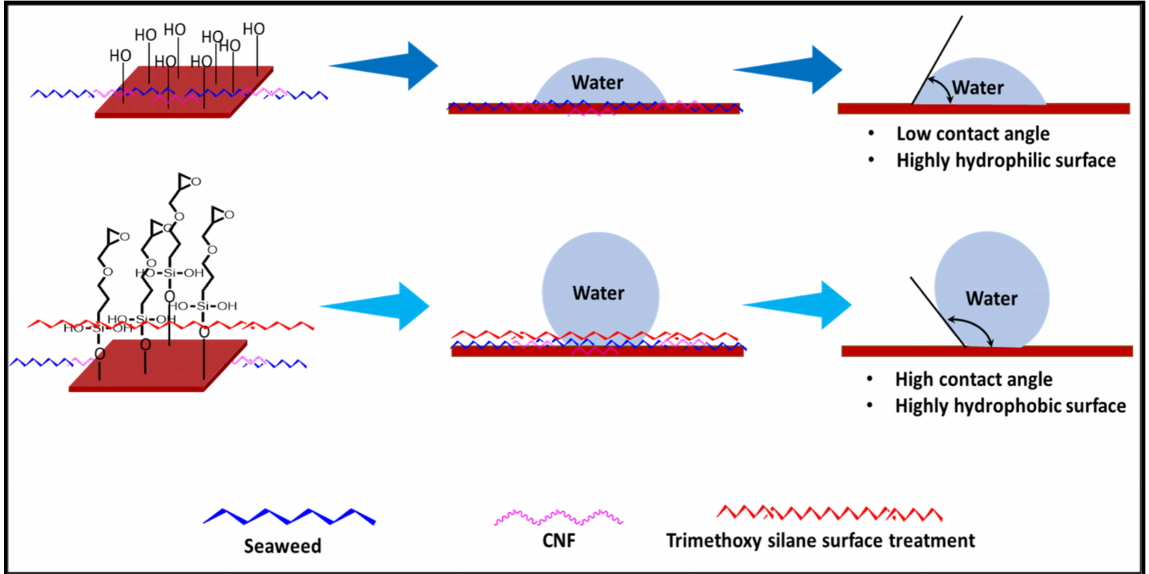
Figure 4. Silane modification effect on seaweed film contact angle.